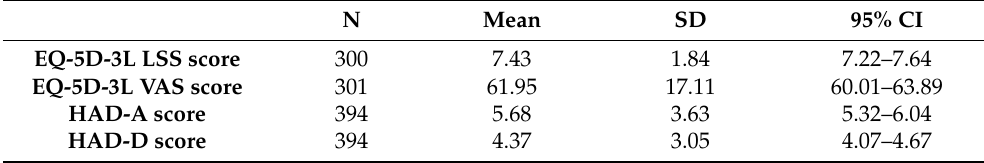
Table 3. Overall results of the EQ-5D-3L and HAD scales.